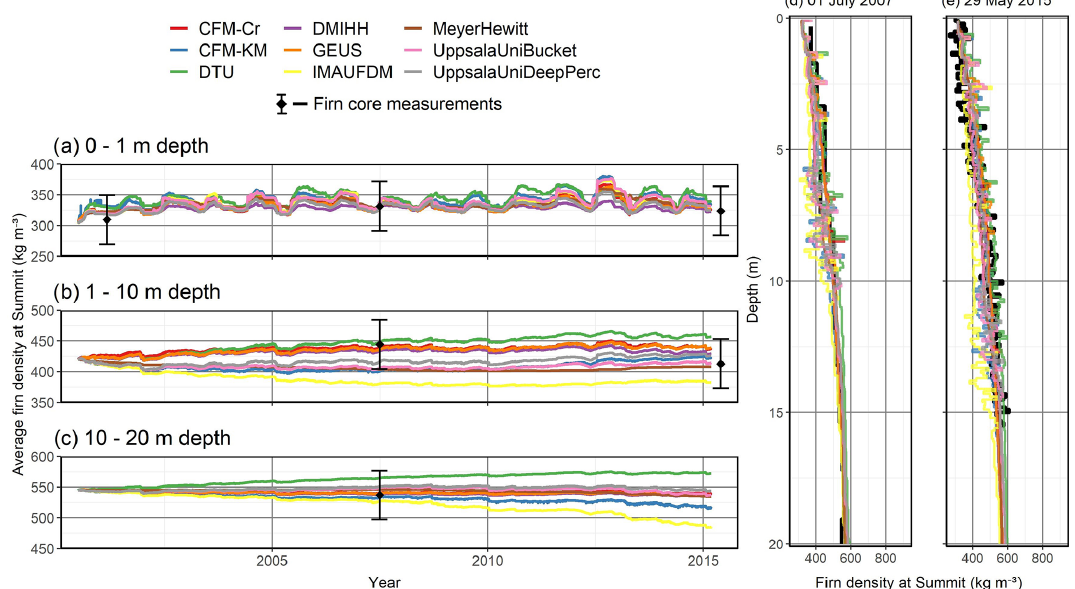
Figure 3. Modeled (colored lines) and observed (black diamonds with ± 40kgm − 3 uncertainty bars) average firn density for the 0–1m (a) , 1–10m (b) and 10–20m depth range (c) at Summit. Note the different density scales. Comparison of simulated and observed firn density profiles (d, e) . In (e) the last modeled density profiles, from 8 March 2015, are compared to an observation from 29 May 2015.